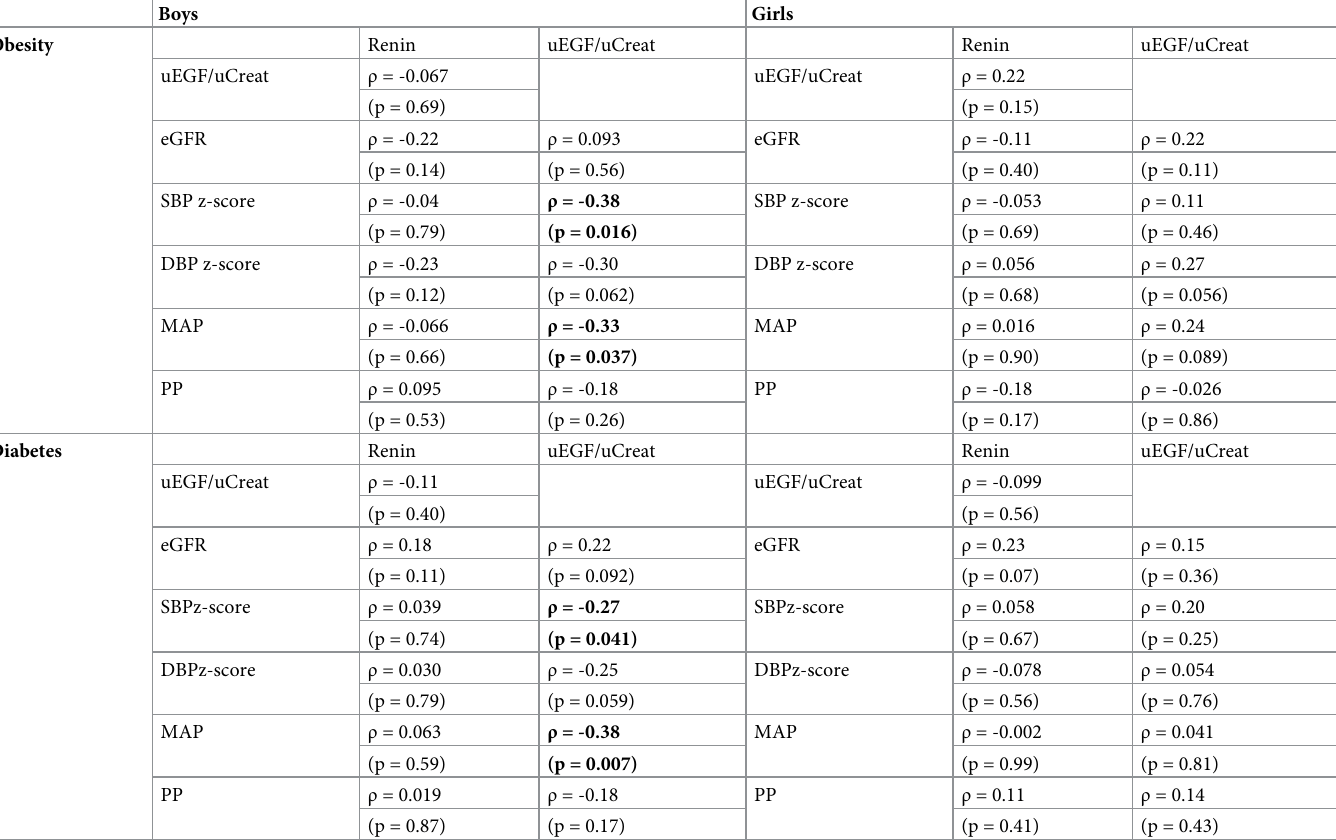
Table 2: In this table the partial correlations are presented between renin and related parameters and uEGF/uCreatinine and related parameters in boys (left panels) and girls (right panels) with obesity (upper panels) or T1DM (lower panels). Spearman’s rho ( ρ ) controlled for age and height-z-score are shown and the respective p-values. Significant relations are displayed bold (p < 0.05). SBP: systolic blood pressure; DBP: diastolic blood pressure; MAP: mean arterial pressure; PP: pulse